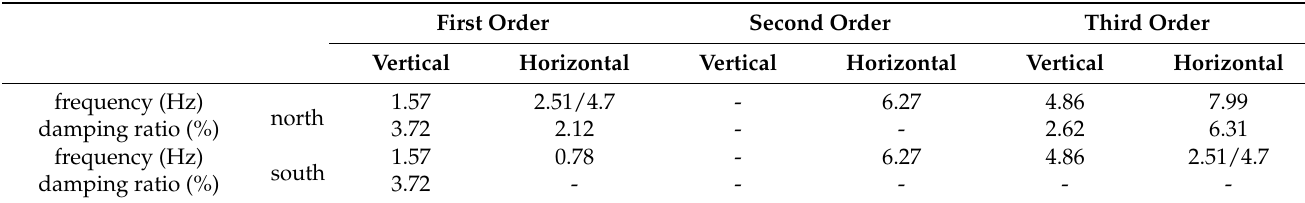
Table 2. Modal parameters of 30 m span and five support AERORail.